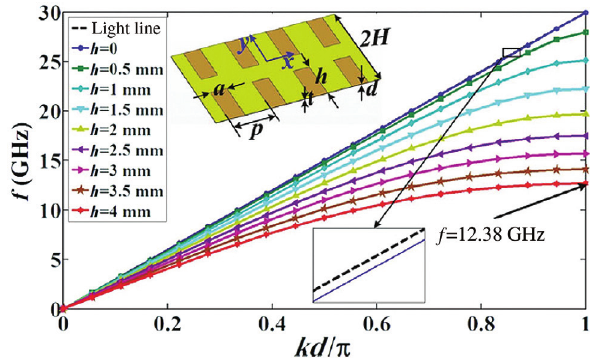
Figure 14: The dispersion curves of two-side metallic grooves with ultrathin thickness printed on a flexible dielectric film. The inset displays the corrugated metal plate with p = 5 mm, a = 2 mm, H = 5 mm, t = 0.018 mm, and d = 0.05 mm. Reproduced from [43] with